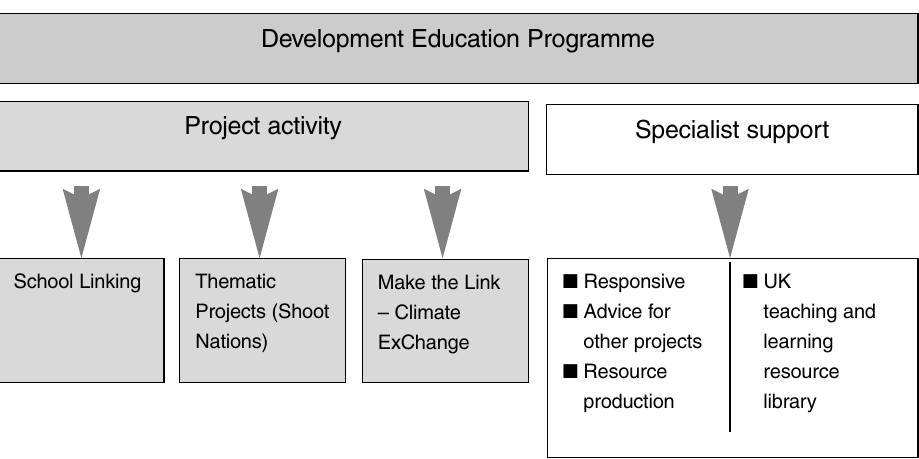
Table 1: Structure of Plan Development